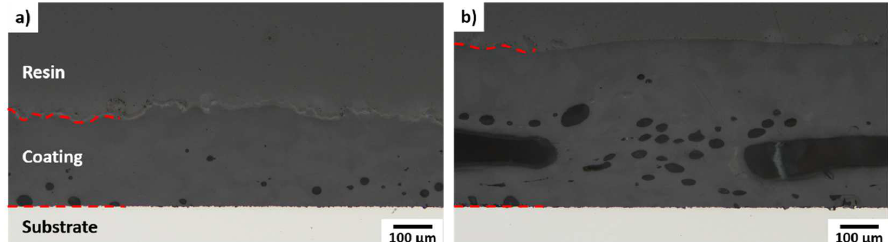
Figure 8. Exemplary microscopic images of polished cross-sections of PA12 coatings deposited by a powder mass flow of 0.6 g/min and different energy densities of ( a ) 2.1 J/mm 2 and ( b ) 2.9 J/mm 2 .